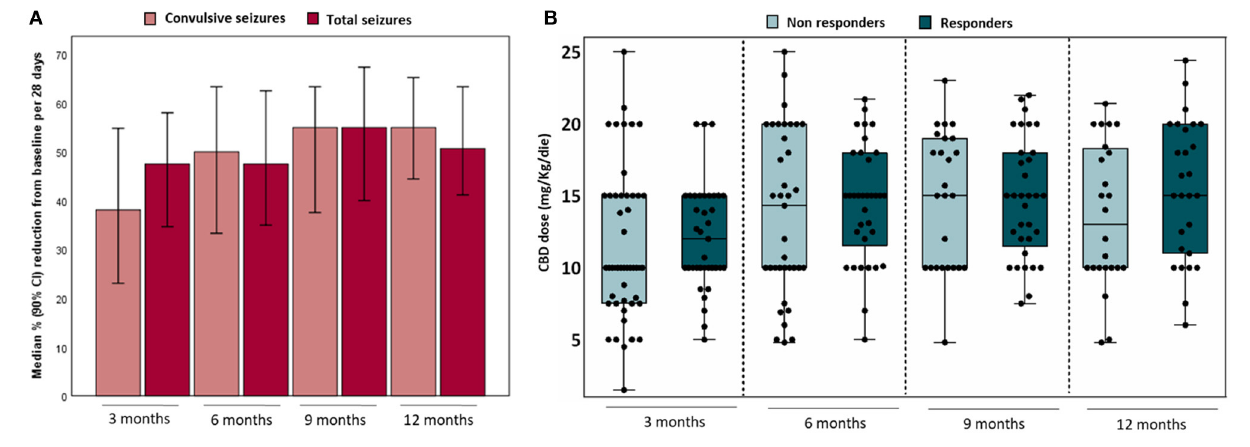
TABLE 3 | Dosing information coadministered ASMs. ASMs dose adjustment at all visits, n (%) Baseline dose stable 39 (74.5) 26 (76.5) 16 (76.2) Baseline dose increased 1 (1.9) 0 0 Baseline dose